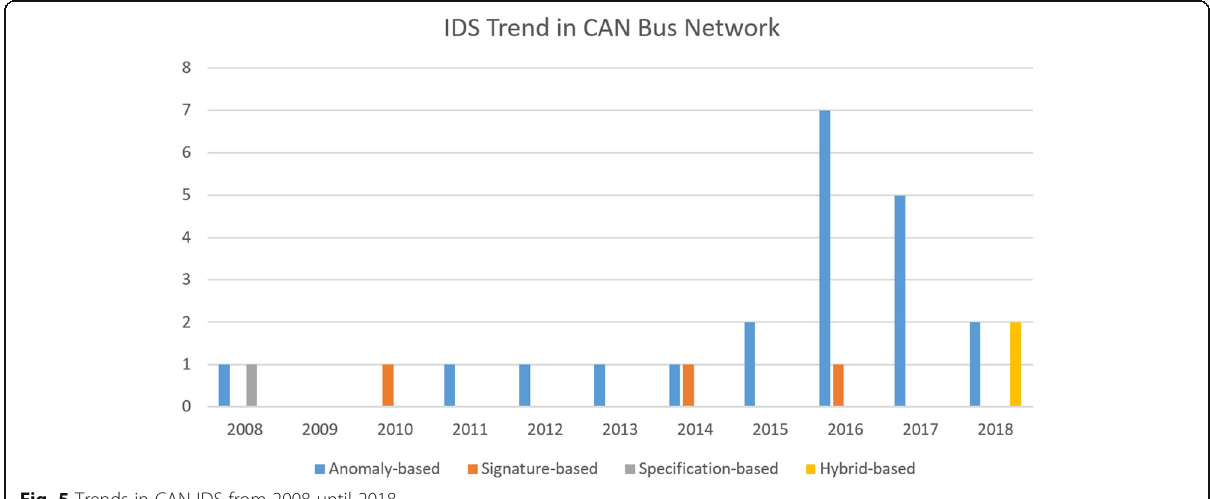
Fig. 5 Trends in CAN IDS from 2008 until